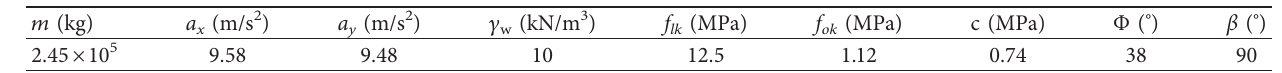
Table 3: Calculation parameters.